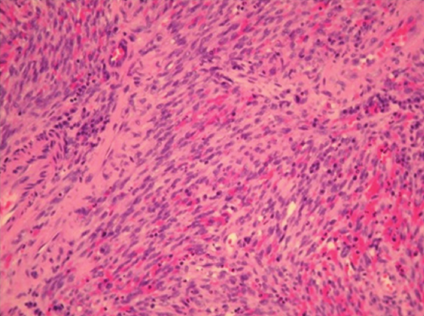
multiple lymph nodes of variable size, associated with a 3 cm